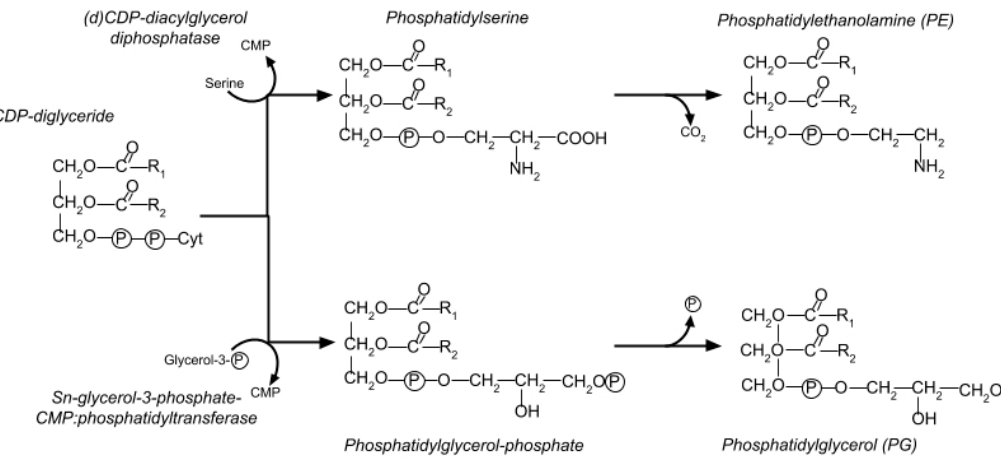
Figure 8. Biosynthesis pathway of PG and PE. Synthesis of both PG and PE begins by converting glycerol-3-phosphate to phosphatidic acid and thence into CDP-diglyceride, at which point the two pathways branch. For PE, CDP-diglyceride is converted into phosphatidyl serine and then into PE. The PG synthetic path converts the CDP-diglyceride into phosphatidylglycerol phosphate and then into PG.